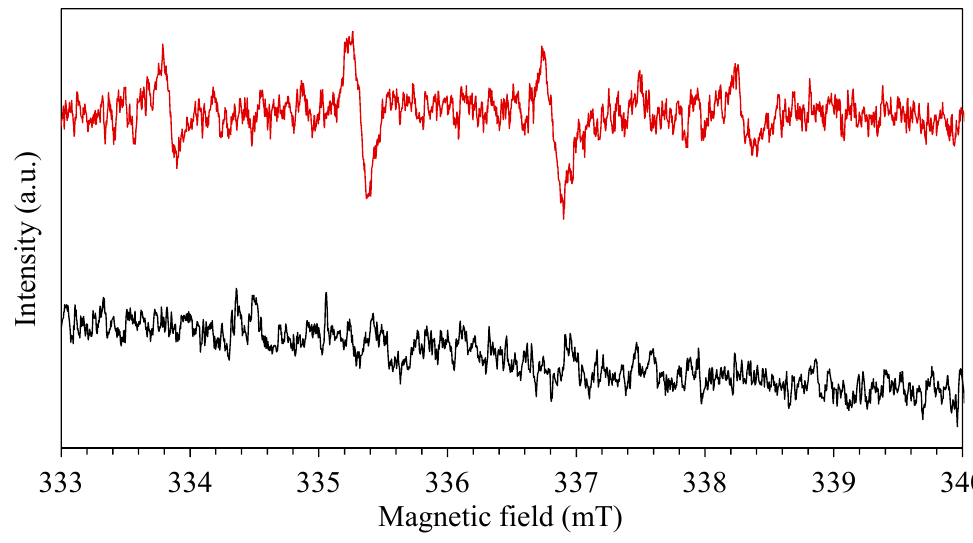
Figure 10. EPR spectra using DMPO as spin-trap in presence of RhB , red with catalyst and black without catalyst.